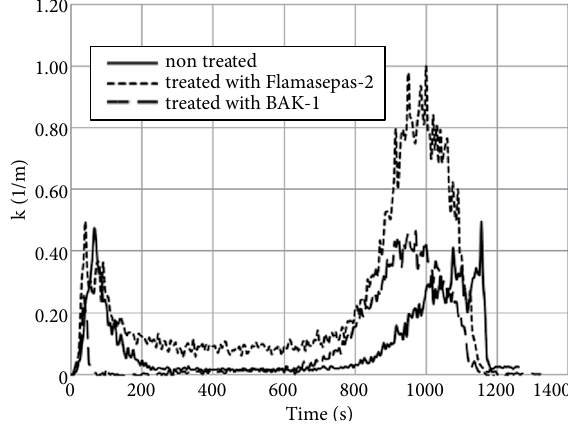
Fig. 7. A peak of CO yield obtained during the last stage of combustion (time interval: 1175–1325 s) of non-treated and treated specimens in the cone calorimeter at the heat flux of 30 kW/m 2 (with piloted ignition)